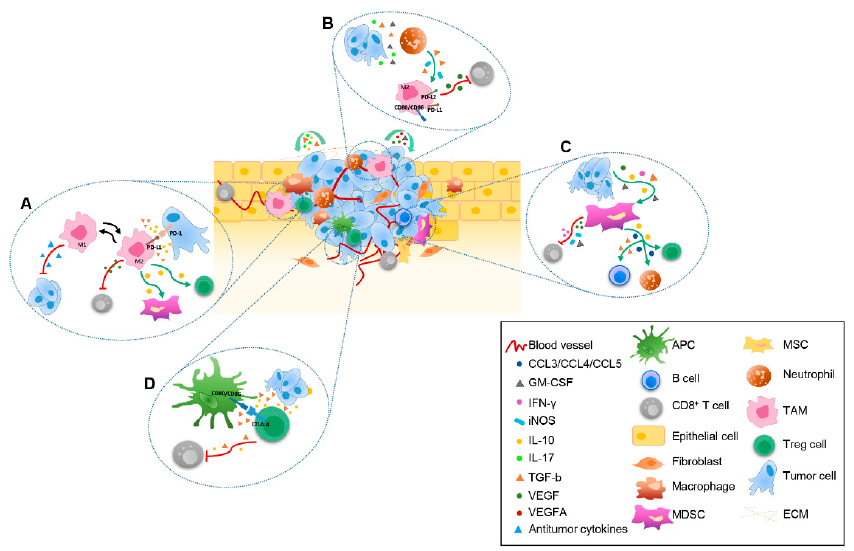
Figure 1. The dynamic crosstalk within tumor microenvironment (TME). Schematic representation of the main mechanisms underlying the interaction among extracellular matrix (ECM), stromal cells, tumor cells and infiltrating immune cells driven by released immunosuppressive cytokines and chemokines. The following dynamic interactions between cellular components are indicated: ( A ) antigen presenting cells (APC), tumor cells, regulatory T cell (Treg) and CD8 + T cells; ( B ) tumor cells, neutrophils, tumor-associated macrophages (TAM) and CD8 + T cells; ( C ) tumor cells, TAM, Treg cells, myeloid-derived suppressor cell (MDSC) and CD8 + T cells; ( D ) tumor cells, MDSC, CD8 + T cells, B cells, neutrophils and Treg cells.APC, Antigen presenting cell; ECM, extracellular matrix; MDSC, myeloid-derived suppressor cell; MSC, mesenchymal stem cell; TAM, tumor-associated macrophage; Treg, regulatory T cell.